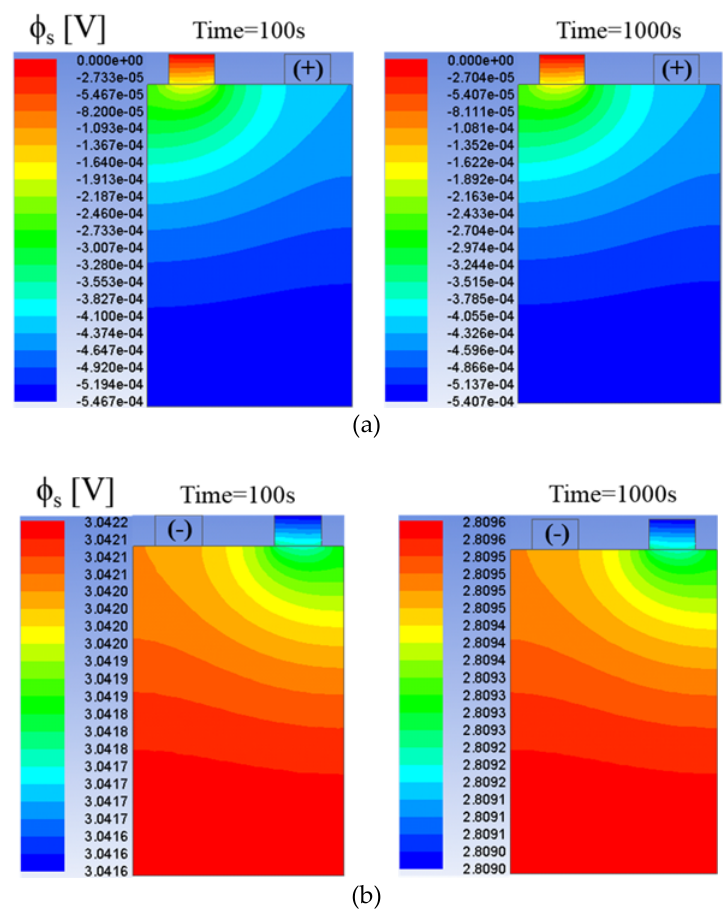
Figure 13. Solid potential distributions on ( a ) the negative and ( b ) positive current collectors at a 2C rate for two different discharge elapsed times of 100 s and 1000 s.